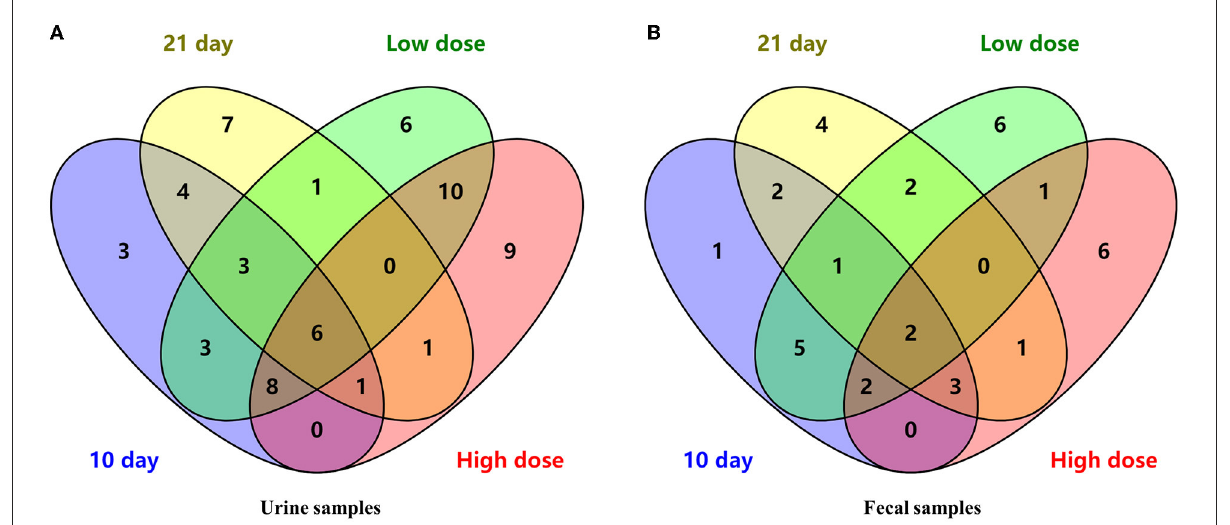
FIGURE3 The Venn diagram of differential metabolites in urine (A) and fecal (B)